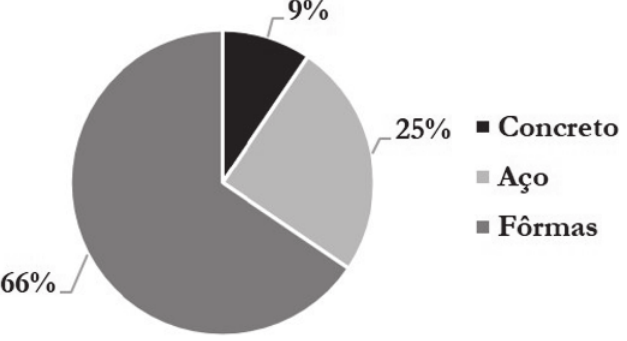
Figura 11 Porcentagem dos custos dos materiais no custo total das seções